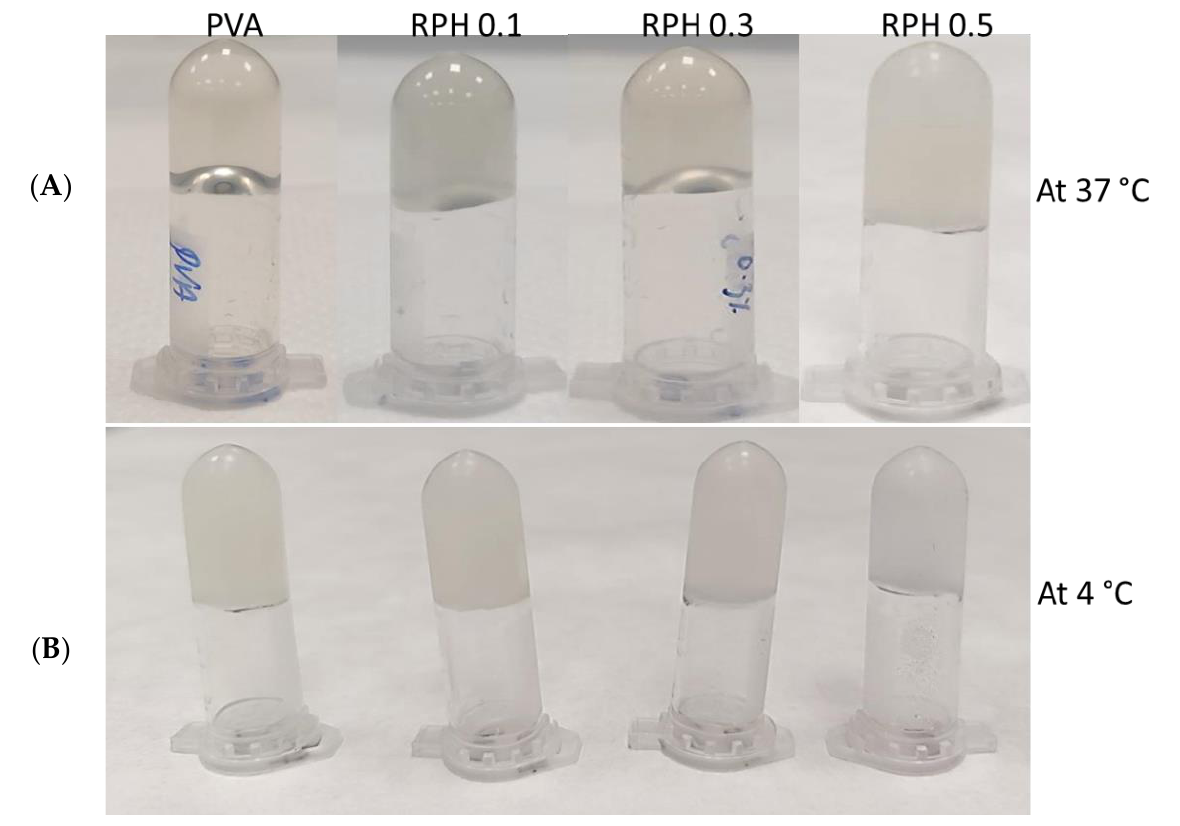
Figure 3. Gelling behavior of retinol-loaded PVA hydrogel at 37 °C ( A ) and 4 °C ( B ). PVA solution 15 wt%, RPH 0.1-0.1% retinol PVA, RPH 0.3-0.3% retinol PVA, and RPH 0.5-0.5% retinol PVA hy- drogel.